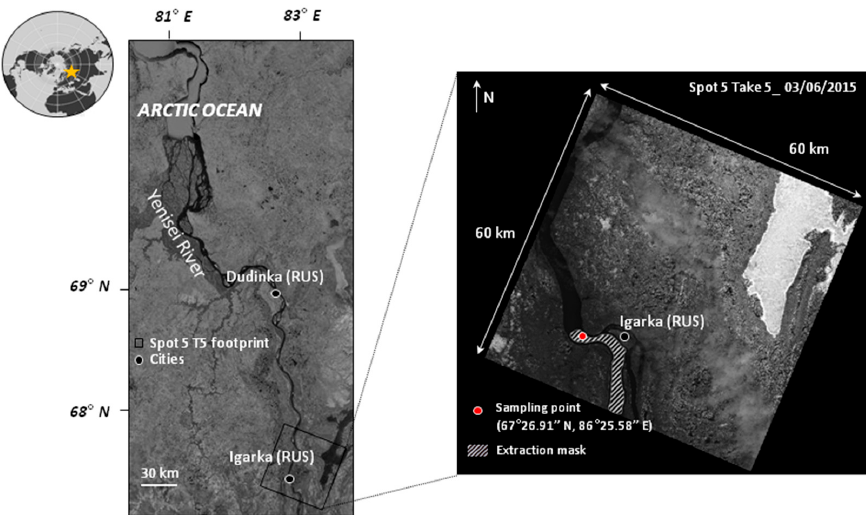
Figure 1. Map showing the sampling site of DOC and CDOM in the Yenisei River. In 2015, SPOT5 Take5 acquisitions were synchronous with field measurements. Water-leaving reflectances at the sampling location were extracted from an extraction mask.